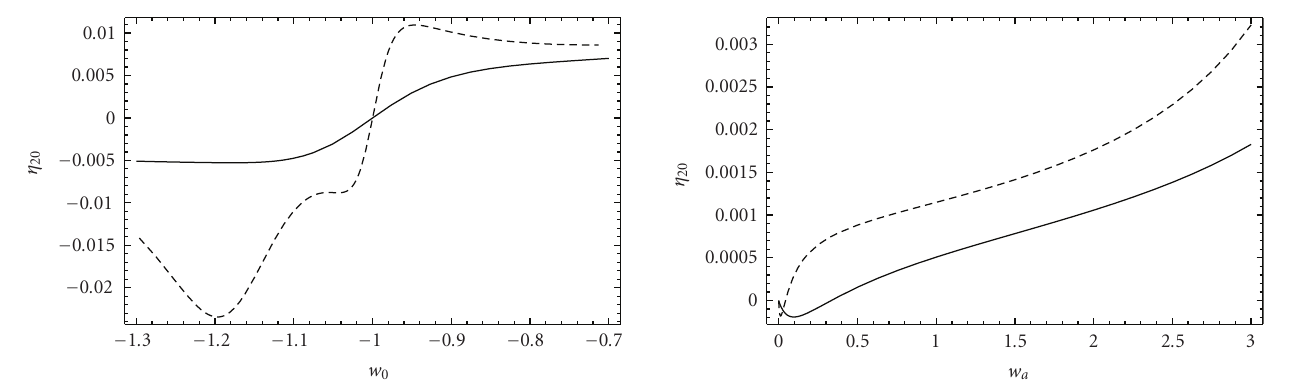
Figure 3: The dimensionless ratio between the present day values of f (cid:7)(cid:7) ( R ) and f ( R ) as function of the w a parameter for models with w 0 = − 1. Short dashed and solid lines refer to models with Ω M = 0 . 041 and 0 . 250, respectively.